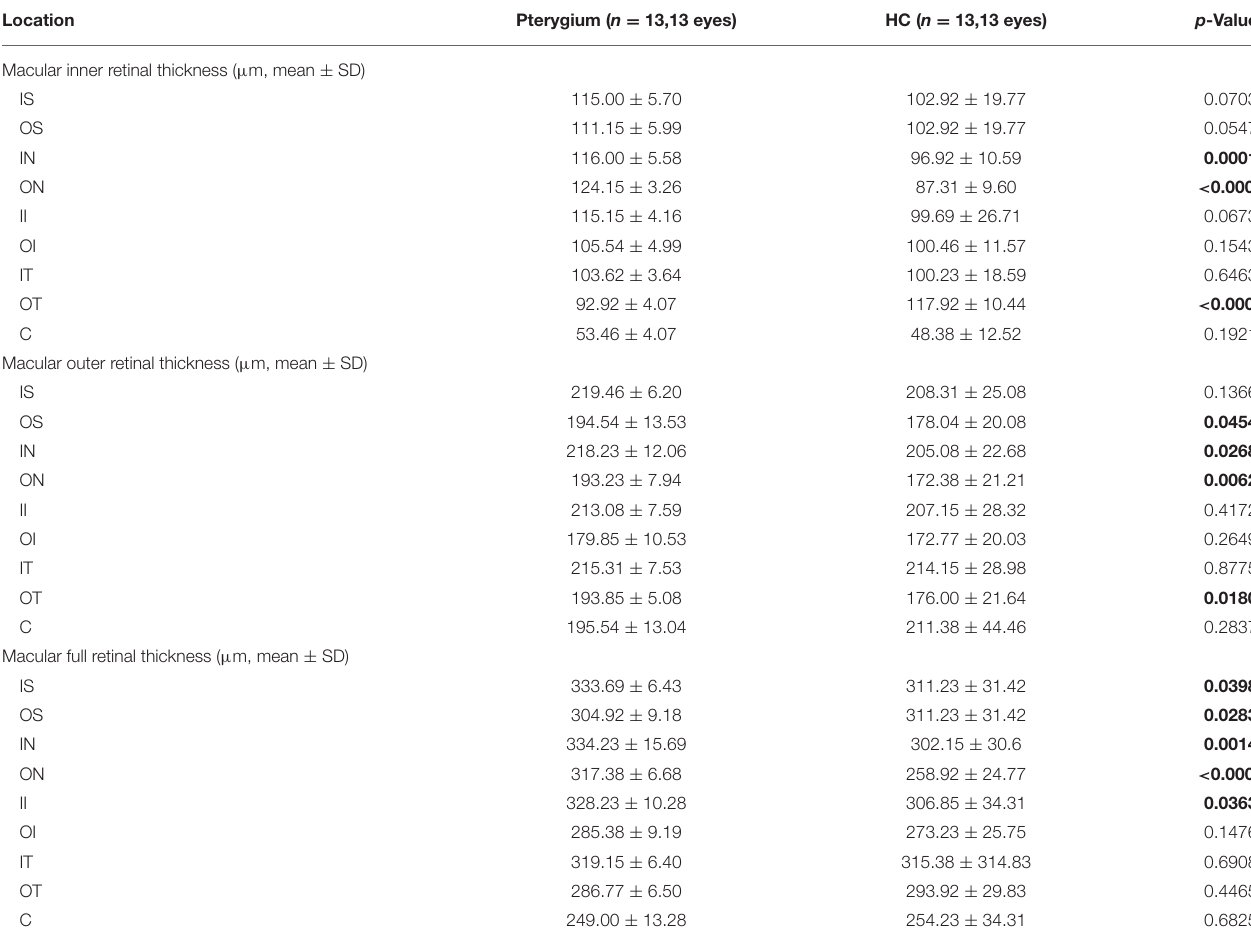
TABLE 2 | Comparison of macular retinal thickness at different locations between patients with Pterygium and health controls.